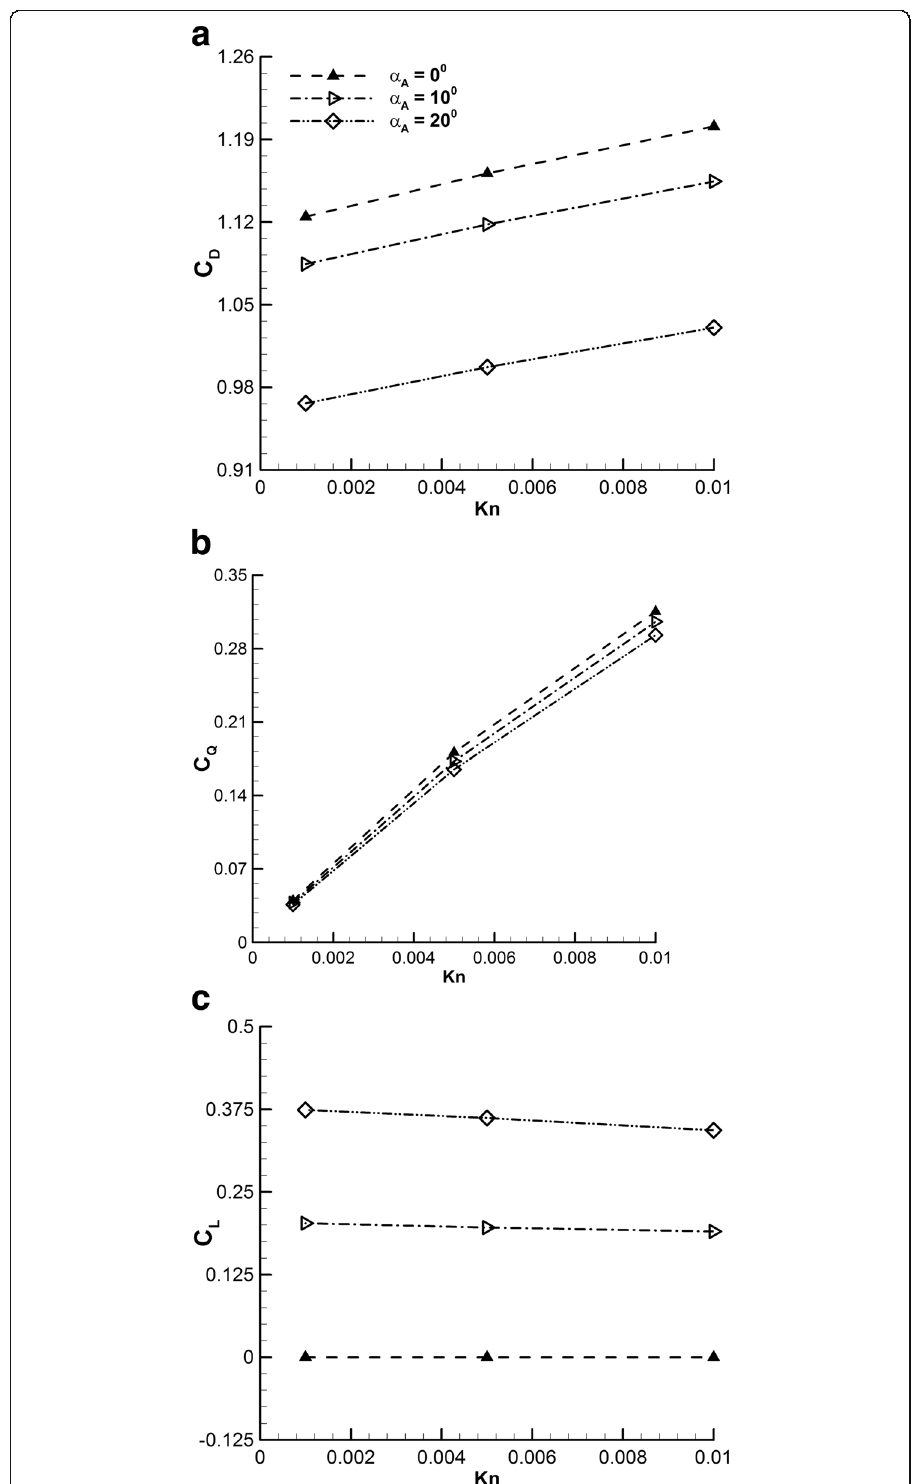
Fig. 22 Comparison of the aerothermodynamic coefficients for varying Knudsen numbers (0.001, 0.005, and 0.01) for different freestream angles of attack at M = 6: a drag coefficient, b heat flux coefficient, and c lift